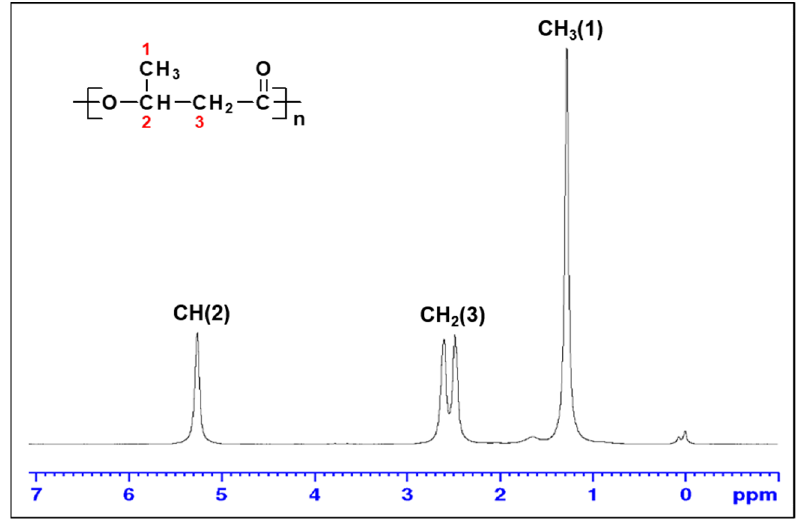
Figure 6. 1 H NMR spectrum (600 MHz) of a PHA biosynthesized by Priestia sp. strain